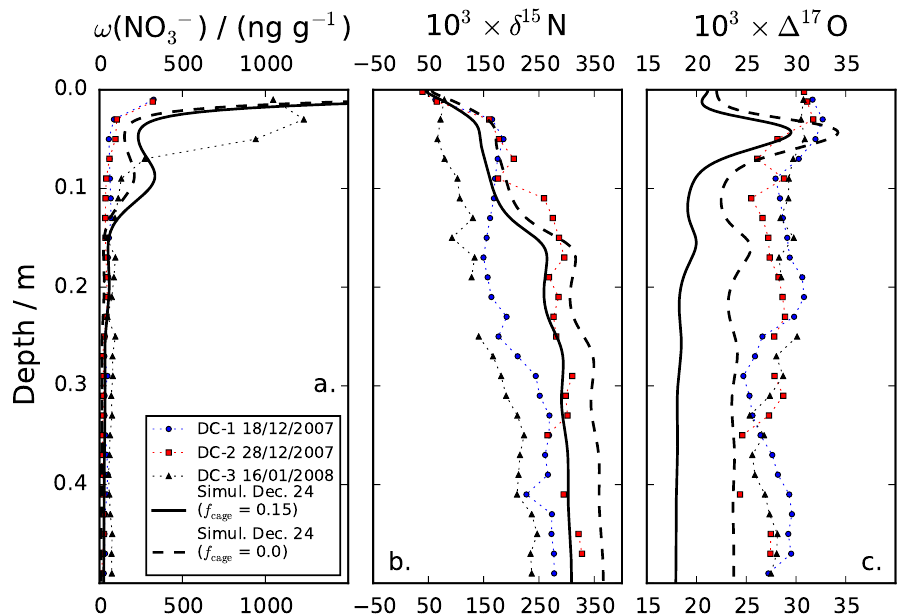
Figure 6. Realistic simulation results: nitrate in the top 50cm of the snowpack on 24 December and comparison to the three observed profiles at Dome C in summer 2007–2008 (Frey et al., 2009; Erbland et al., 2013). (a) Nitrate mass fractions, (b) δ 15 N in nitrate and (c) (cid:49) 17 O in